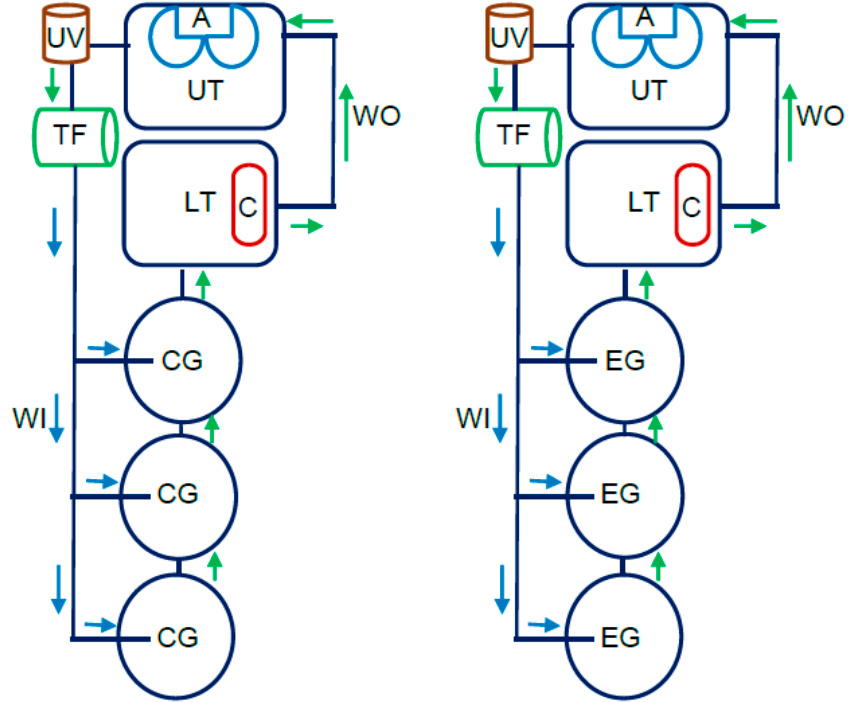
Figure 1. Diagram of juvenile rainbow trout rearing in a recirculating aquaculture system (RAS). Abbreviations: CG—rearing tanks stocked with control group fish; EG—rearing tanks stocked with experimental group fish; LT—lower tank, C—coil heater; A—aerators, UV—UV lamp; TF—trickling filter; WI—water inflow; WO—water outflow.